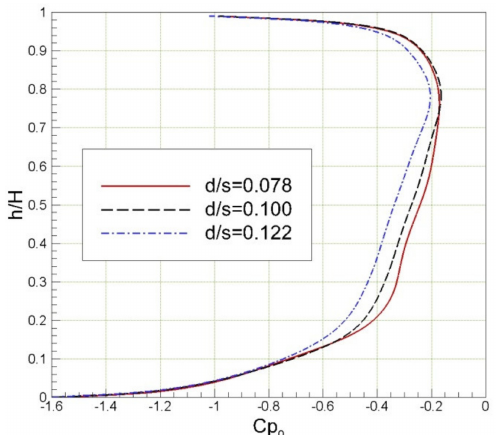
Figure 17. Radial distribution of the pitchwise averaged total pressure coefficient at the outlet of the